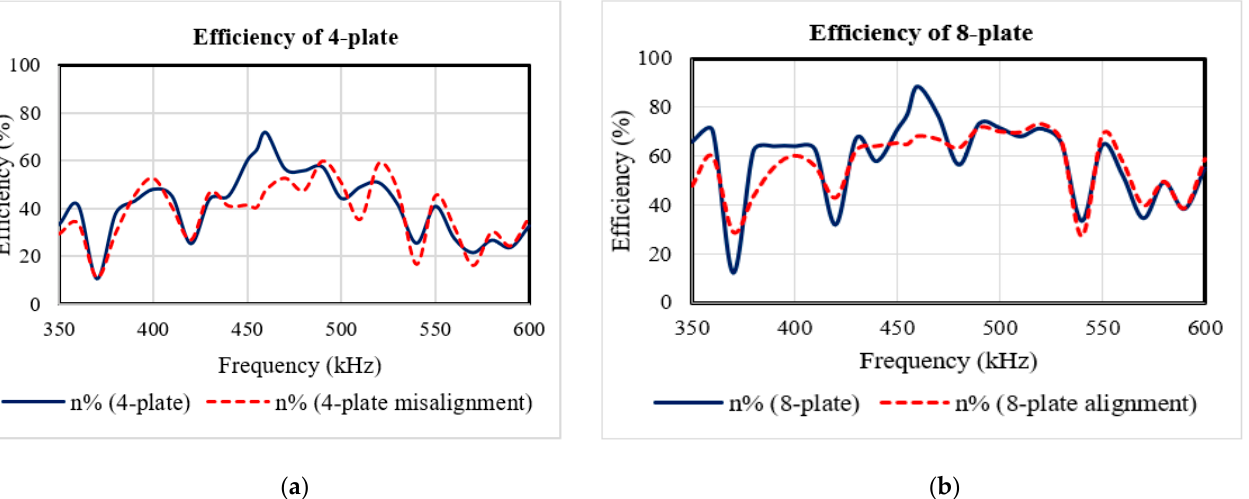
Figure 10. Efficiency of class-E 2 CPT with and without misalignments: ( a ) 4-plate coupling and ( b ) 8-plate coupling.